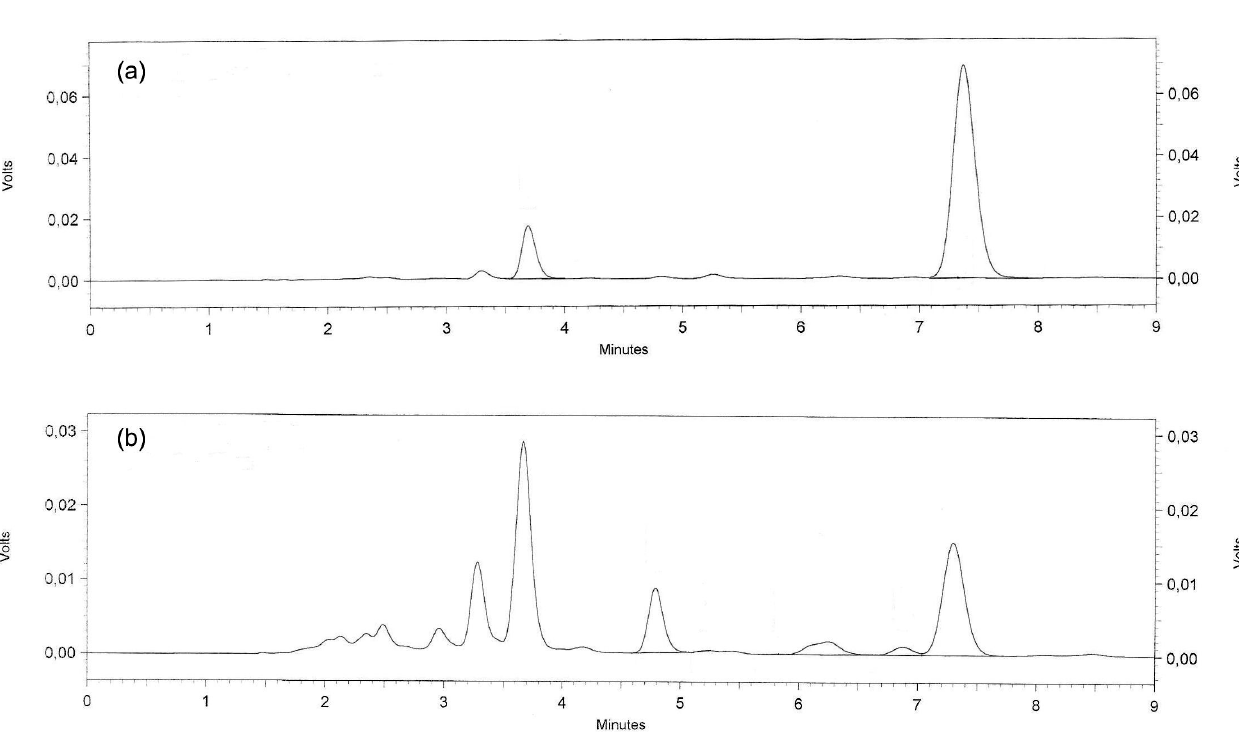
FIGURE 4 - Chromatograms corresponding to: (a) solution of DP reference substance time 5 hours and (b) solution of DP reference substance time 24 hours after photolytic conditions.